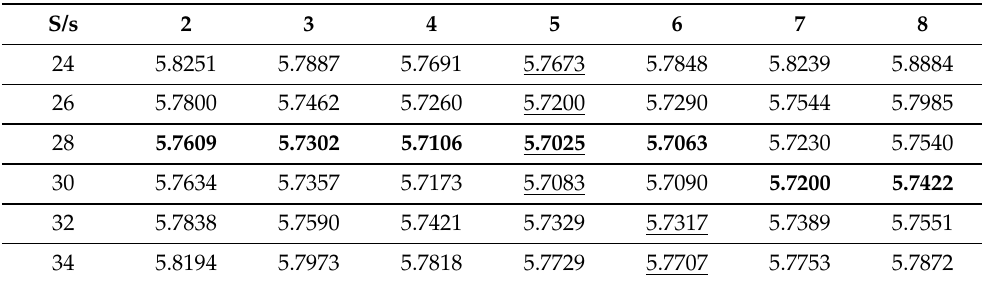
Figure 7. The total expected cost value for different values of β 1 and β 2 . Table 1. Total expected cost rate as a function of s and S.